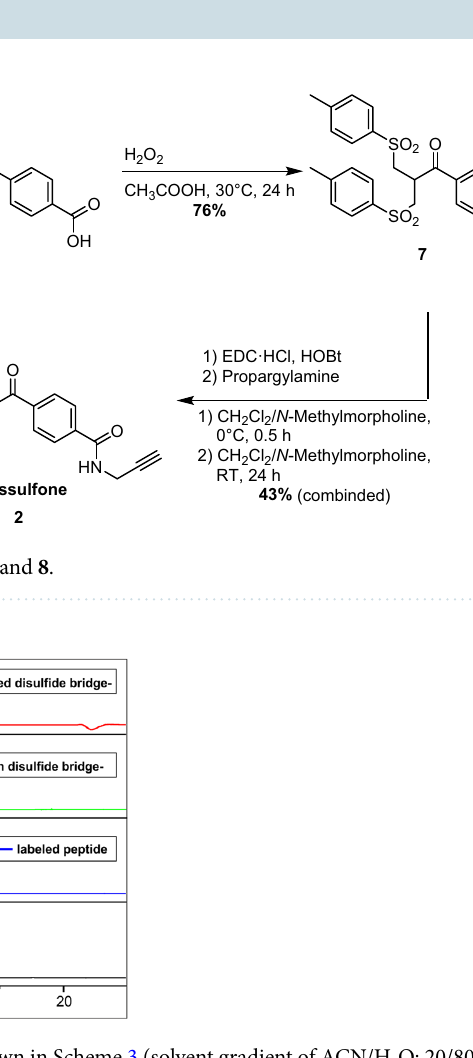
Figure 1. HPLC traces of the labeling process shown in Scheme 3 (solvent gradient of ACN/H 2 O: 20/80 to 80/20, λ = 214